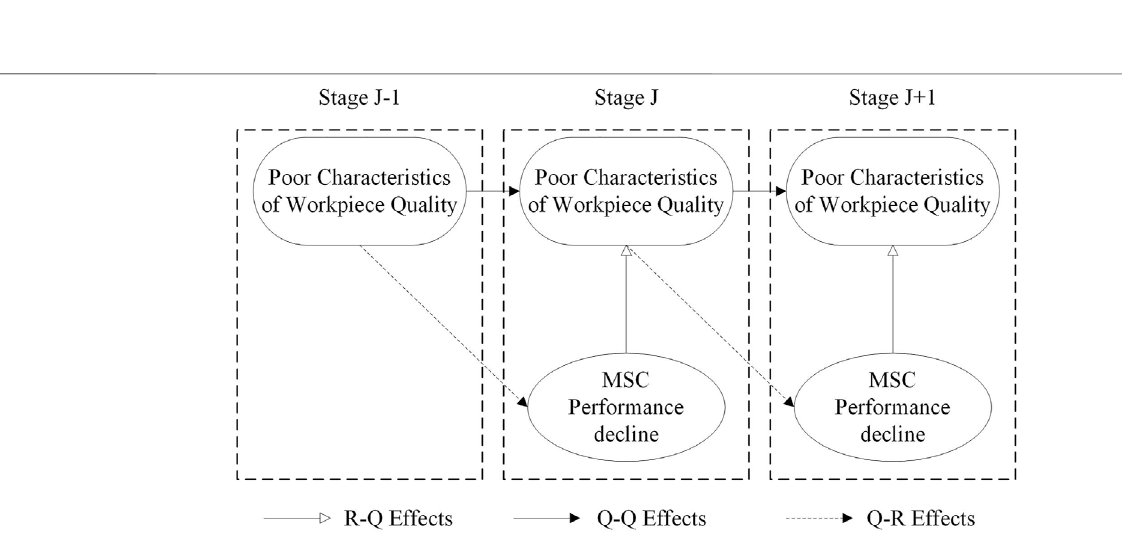
FIGURE 4 | Quality-reliability coupling relationship of multi-stage processing.